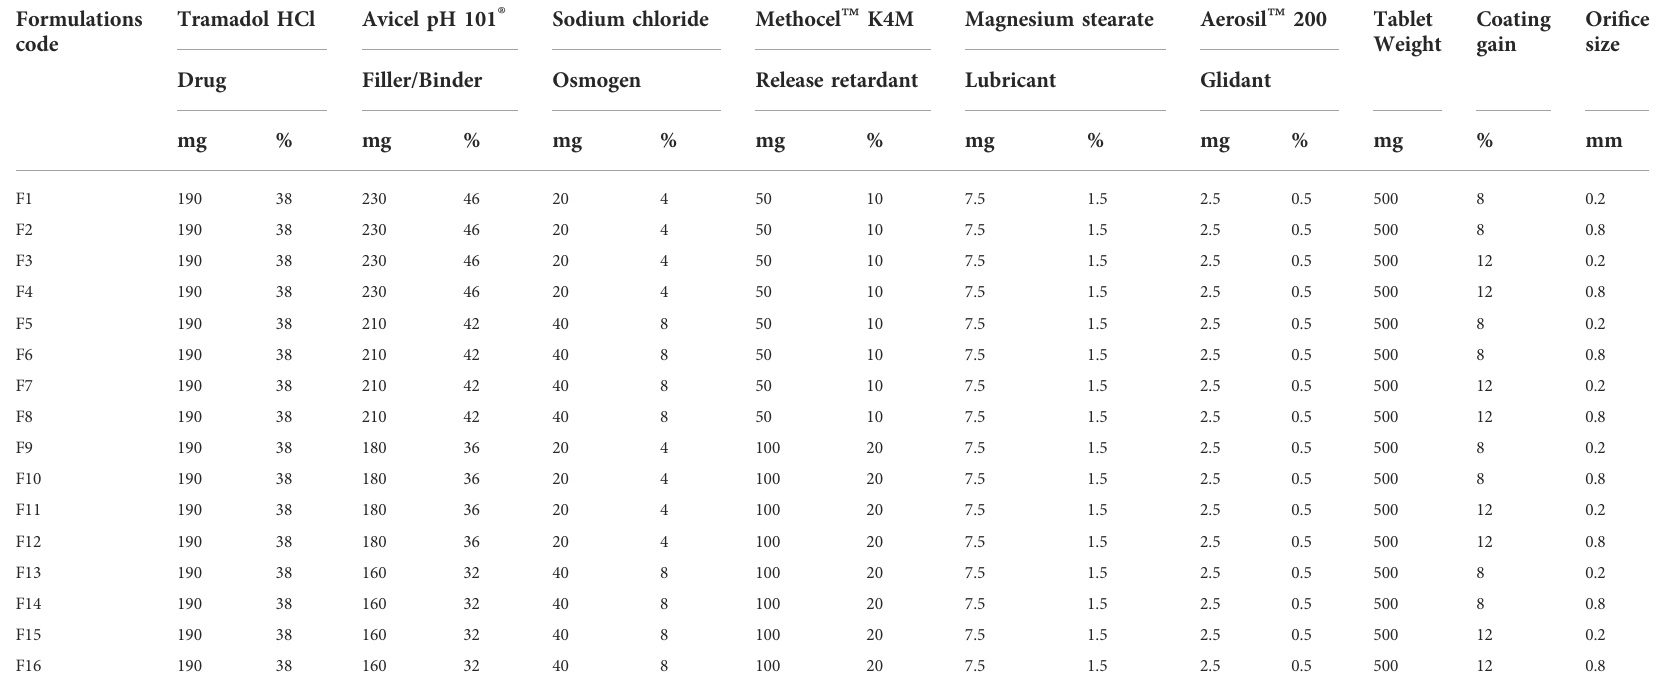
TABLE 4 Composition of tramadol HCl